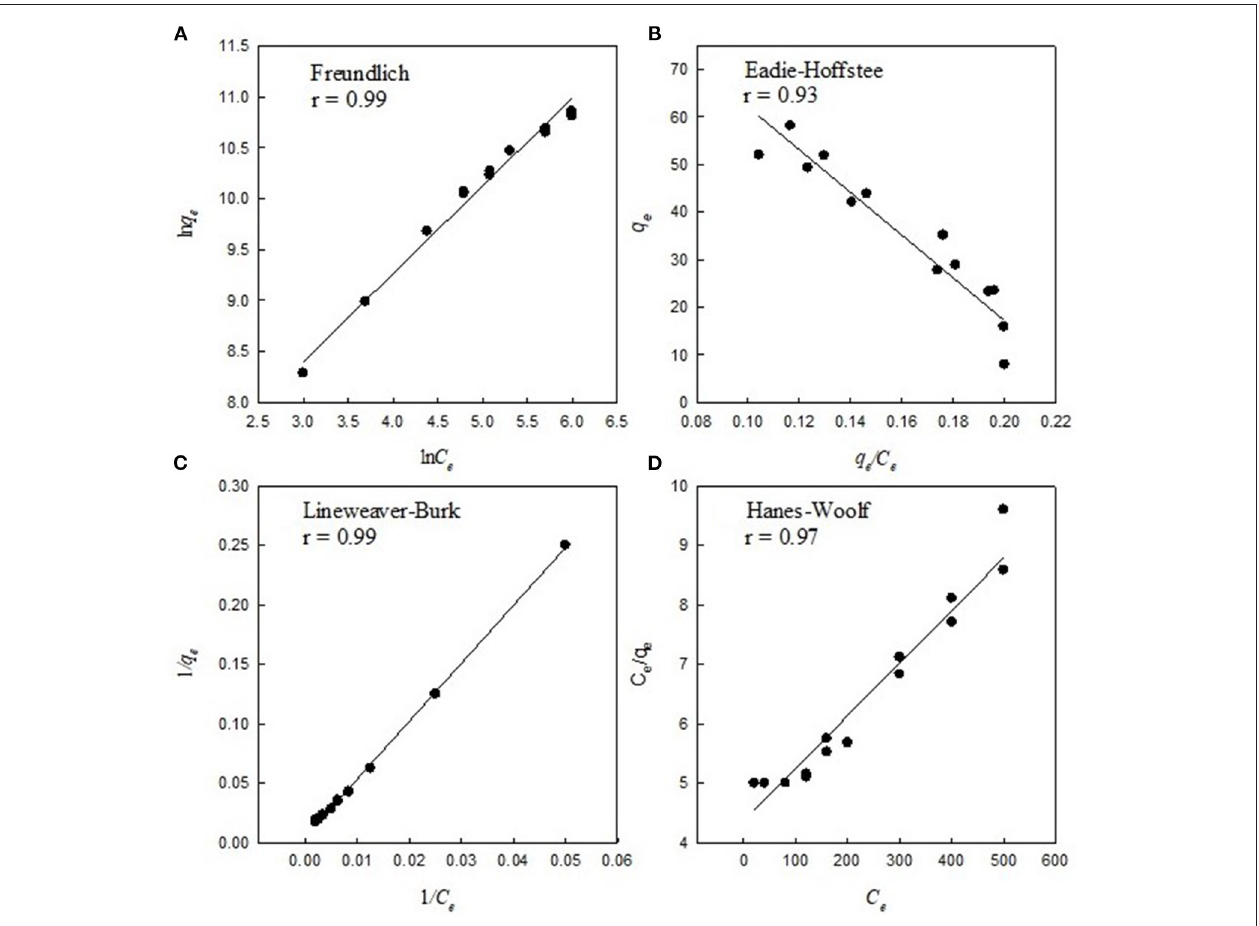
FIGURE 2 | Example linear transformations of Freundlich and Langmuir isotherms for soil 17 in Table 1 . q e is the concentration of ciprofloxacin adsorbed in the soil (in g kg − 1 ) and C e is the concentration of ciprofloxacin in the solution (mg L − 1 ). Each individual soil tested were linearly transformed by Freundlich and the Langmuir linear transformations as described in the materials and methods to obtained adsorption